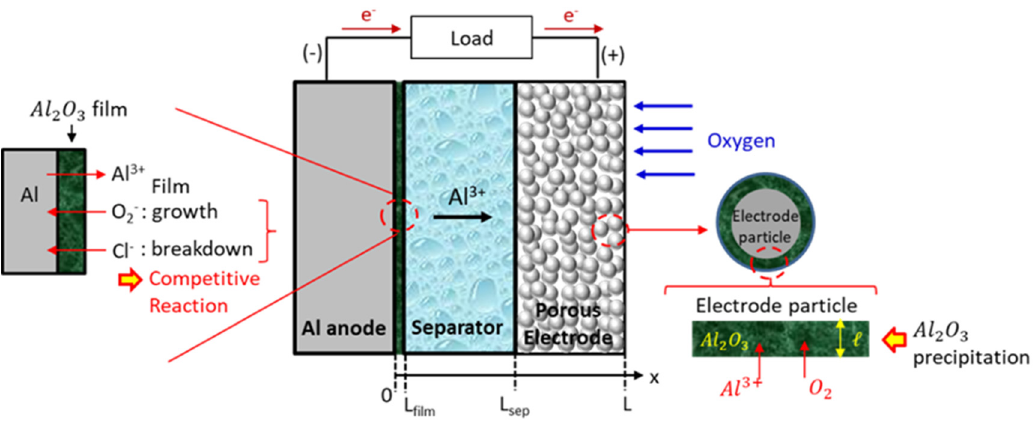
Figure 1. Diagram of Al–air battery discharge.